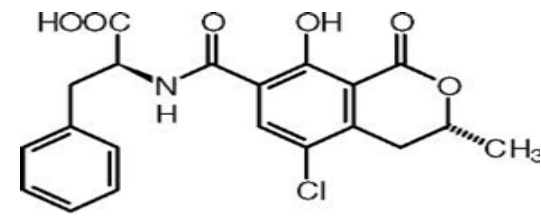
Figure 1. Chemical structure of ochratoxin